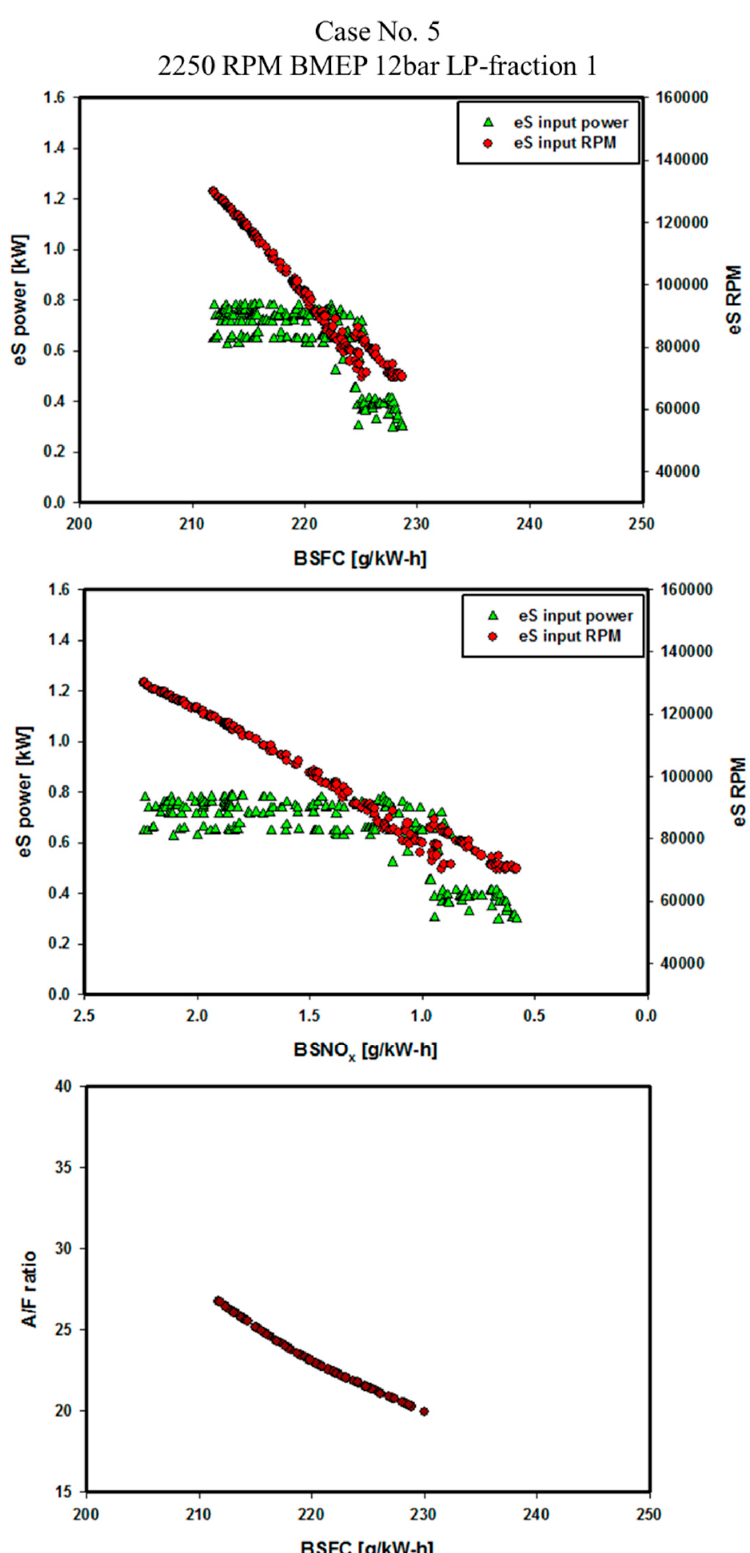
Figure 16. BSFC, BSNO x , and A/F ratio differences on the Pareto front line of case 5 (LP fraction = 1.0).